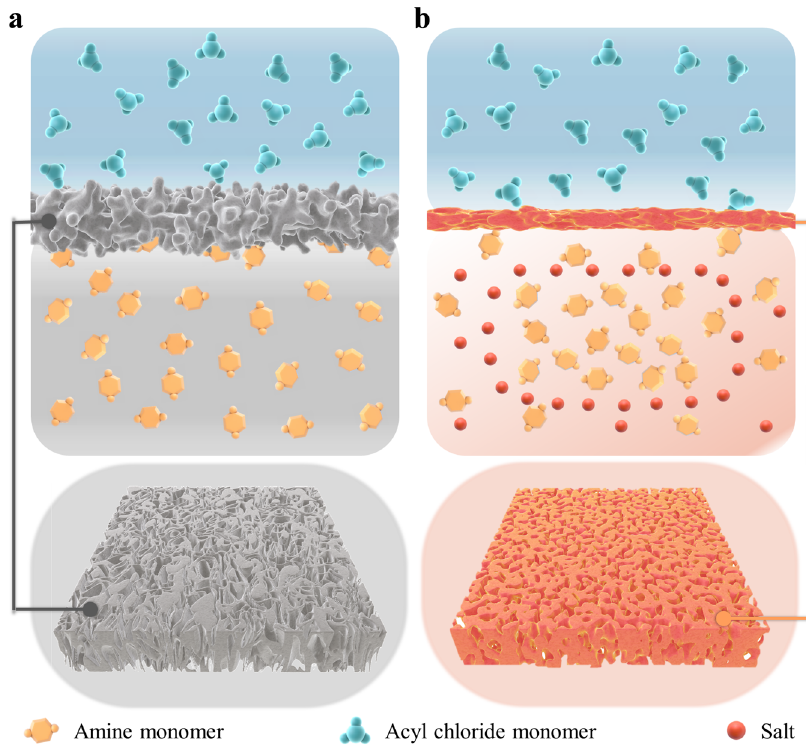
Fig. 1 Schematical illustration of employed IP processes. (a) conventional IP process, (b) salt-participating IP